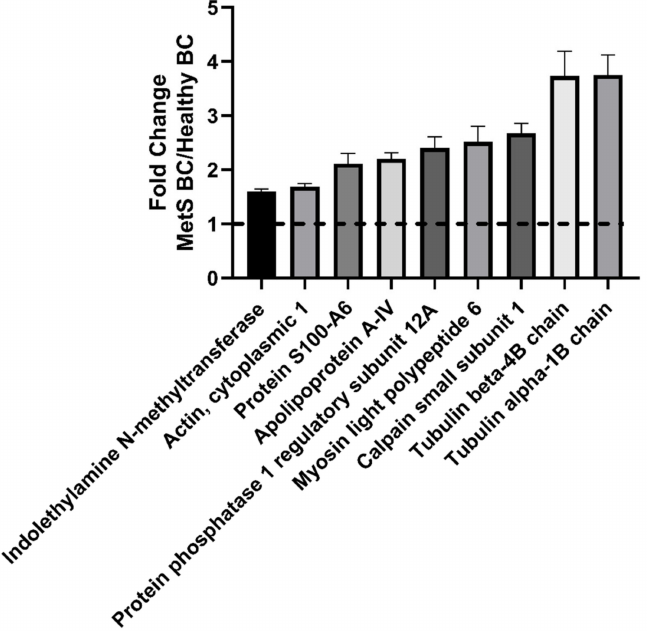
Figure 2. Relative abundance comparison of selected proteins found in healthy and MetS BCs. A value larger than 1 denotes a higher abundance in MetS BC compared to the healthy BC whereas a value less than 1 denotes lower abundance in the MetS BC compared to the healthy BC. All proteins depicted in the figure are significantly different between BCs based on p < 0.05 (n = 4/group). A comprehensive list of protein abundance differences can be found in Table